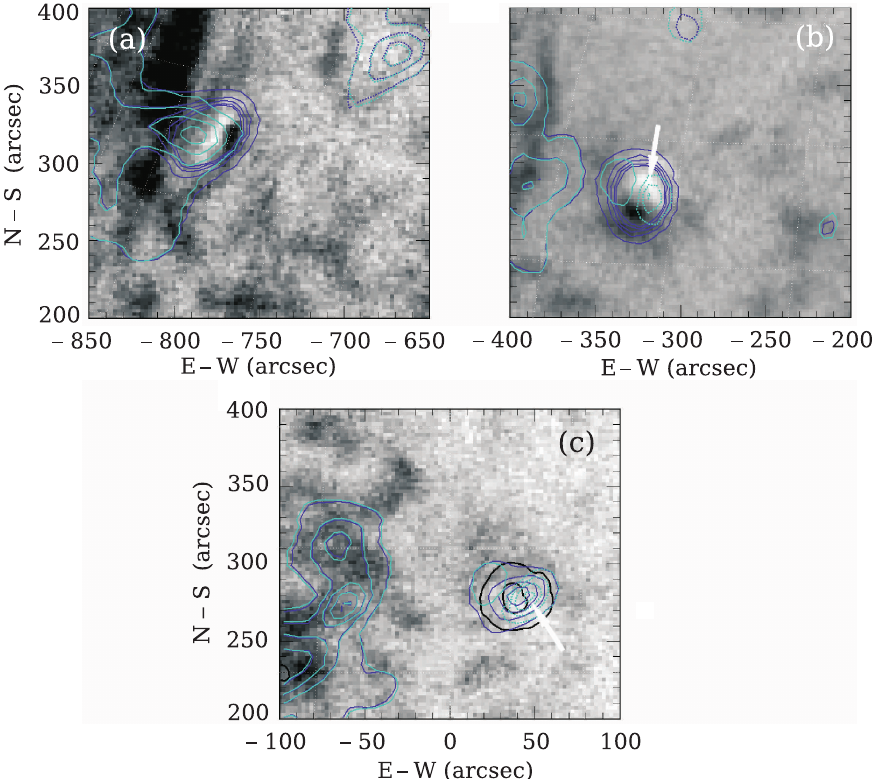
Fig. 3. AR 11312. The image in the chromospheric absorption line He I 1.083 (cid:22) m taken with the CHIP at the Mauna Loa Solar Observatory on (a) October 6 at 01:20 UT and (b) October 9 at 02:10 UT. The contours of the 17 GHz radio brightness taken with the NoRH at 03:50 UT in LCP (violet color) and RCP (azure color) at the levels (12, 15, 18, 21, 24) (cid:2) 10 3 K and (12, 15, 18, 21) (cid:2) 10 3 K, respectively. The dotted line marks radio brightness of (6.5, 7.5, 8.5, 9.5) (cid:2) 10 3 K levels. vertical in the dark patch and from the gyro resonance radiation from the 3rd gyro level for the x-mode at 17 GHz in nearby area of strong magnetic field. The opacity in the area of the free-free radiation depends on propagation angle (cid:11)